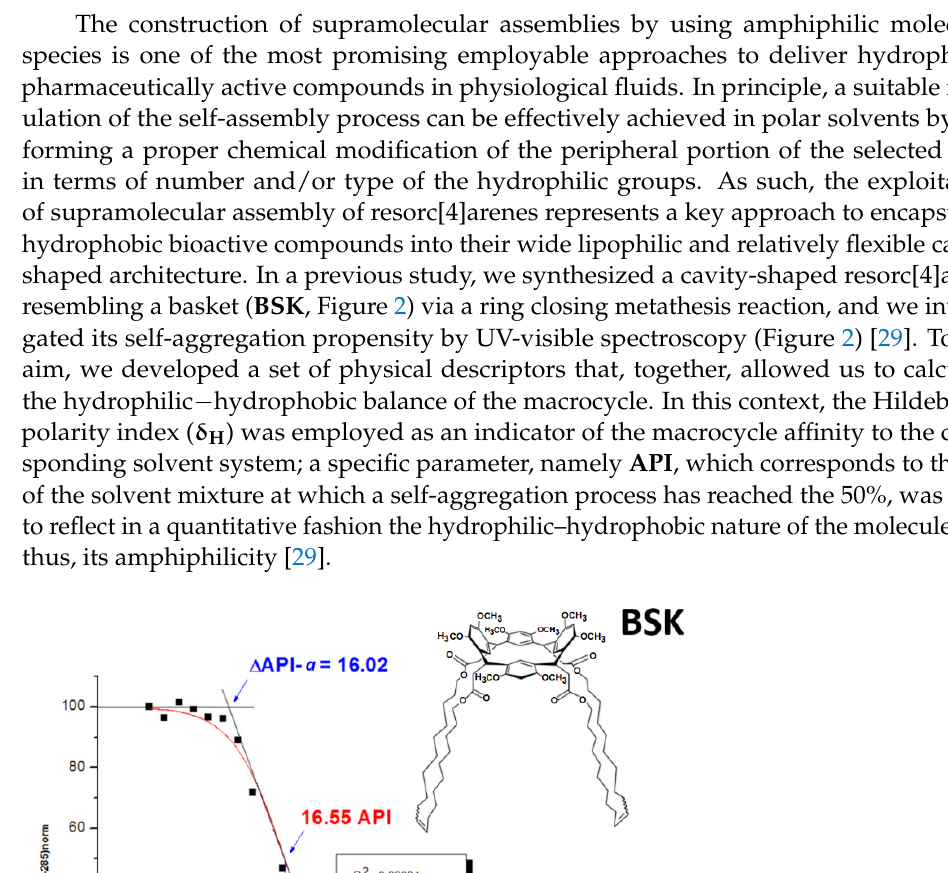
Figure 1. Chemical structure of amphiphilic resorc[4]arenes R1 , R2, and R3 .